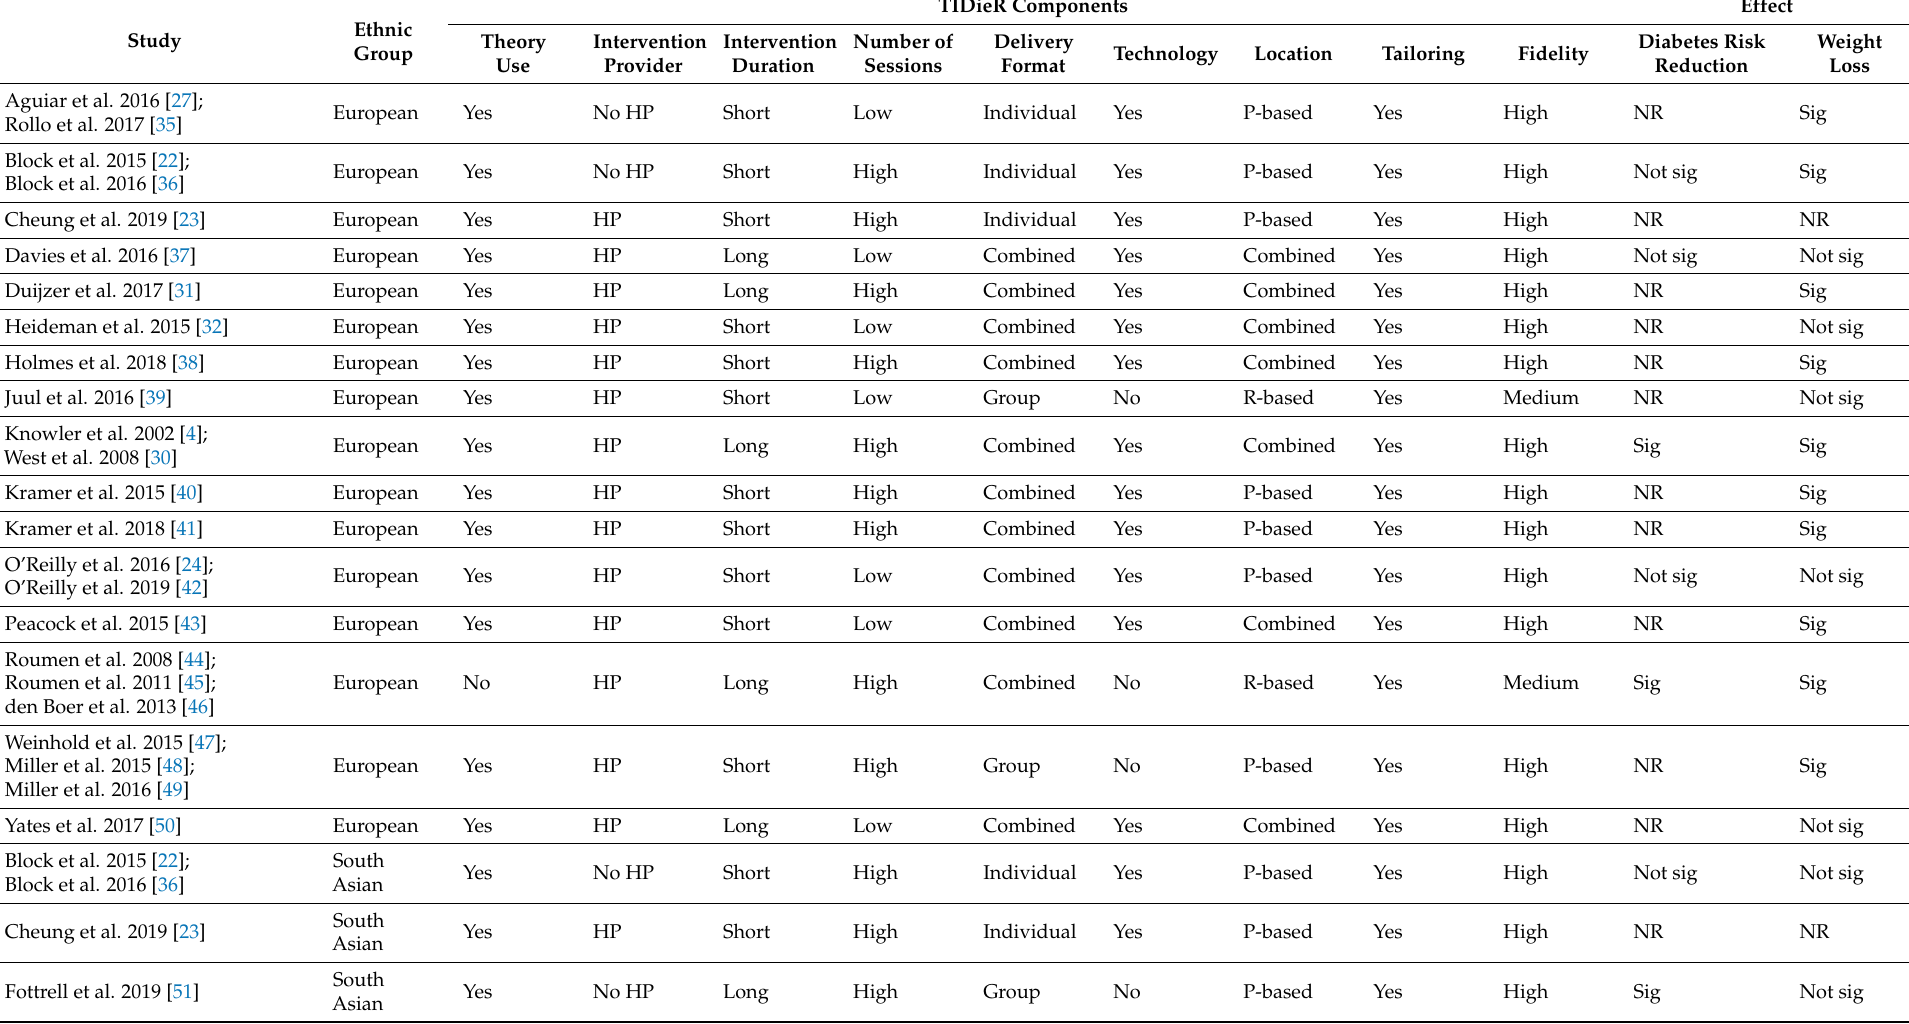
Table 3. TIDieR components and the effects of lifestyle intervention on diabetes incidence and body weight by